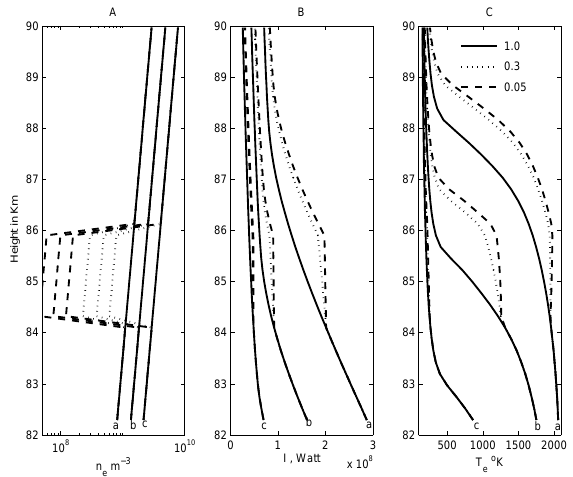
Fig. 2. The heated electron temperatures T e, hot when an electron bite-out is present in the PMSE region, so that the electron den- sity is locally reduced, are shown in C for three different electron densities (A), given by Eq. (4). The cases (A) , (B) and (C) have an electron density at h = 90km of 3 × 10 9 , 5 × 10 9 and 8 × 10 9 m − 3 , respectively, while H = 6km for all cases. In the bite-outs, which we have placed between 84 and 86km, the electron densities are re- duced with factors 0.3 and 0.05, and we have also shown the cases without bite-outs, i.e. with factor 1; ERP=700MW. The intensity of the heater wave for the different cases is shown in Fig. B.